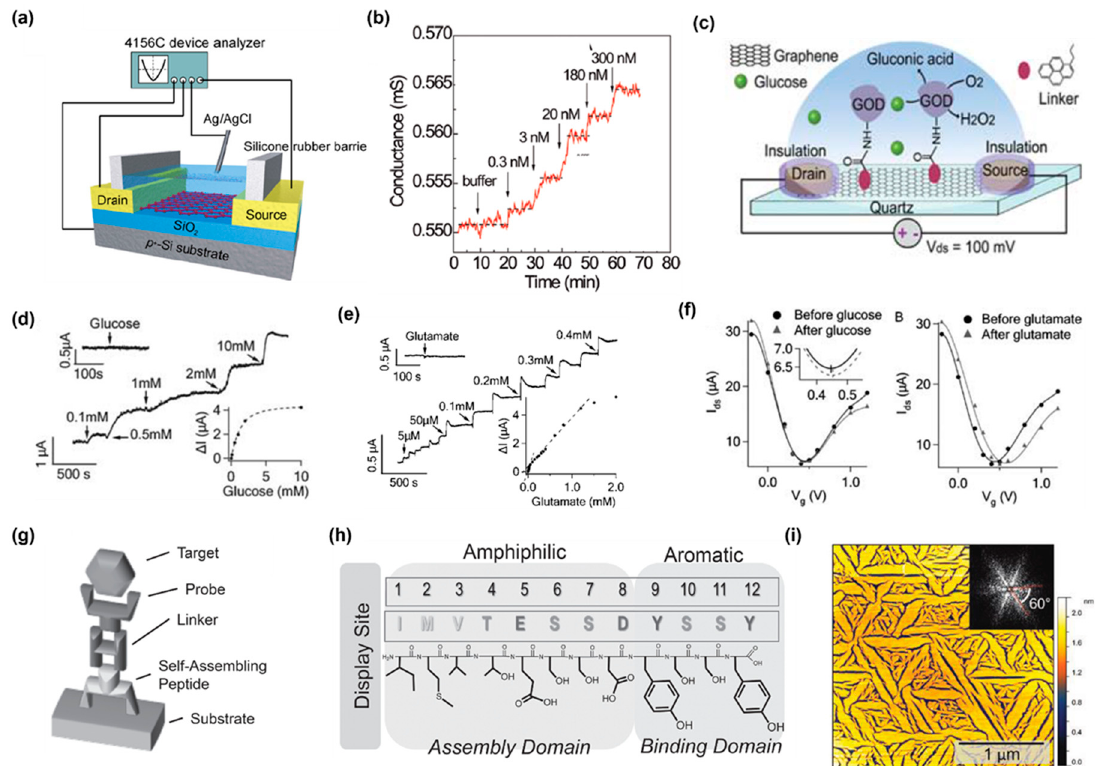
Figure 6. ( a ) Electrolyte-gated graphene FET for protein. ( b ) Real-time conductance changes of the sensor upon exposure to BSA with different concentration. ( c ) Schematic illustration of glucose oxidase (GOD) modified graphene. ( d ) The response of the glucose sensor I D to glucose at various concentrations. The upper insert presents that graphene FET without GOD functionalization shows no response to glucose. The lower insert fits the response of the device and the concentration of glucose into an exponential function. ( e ) The response of the glutamic dehydrogenase (GluD) modified sensor to glutamate of different concentrations in the presence of beta-Nicotinamide adenine dinucleotide ( β -NAD). ( f ) Right: transfer curves of GOD modified graphene with and without the addition of glucose (10mM). Left: transfer cures of GluD modified graphene with and without the addition of glutamate (1mM) in the presence of β -NAD. ( g ) Design of the GrBP5-WT peptide functionalized substrate. ( h ) Chemical structure of GrBP5-WT sequence ( i ) Atomic force microscope (AFM) image of the self-assembled highly ordered peptide on graphite. Insert: FFT of the AFM image. Reprinted with permission from References [99,100,103–105].